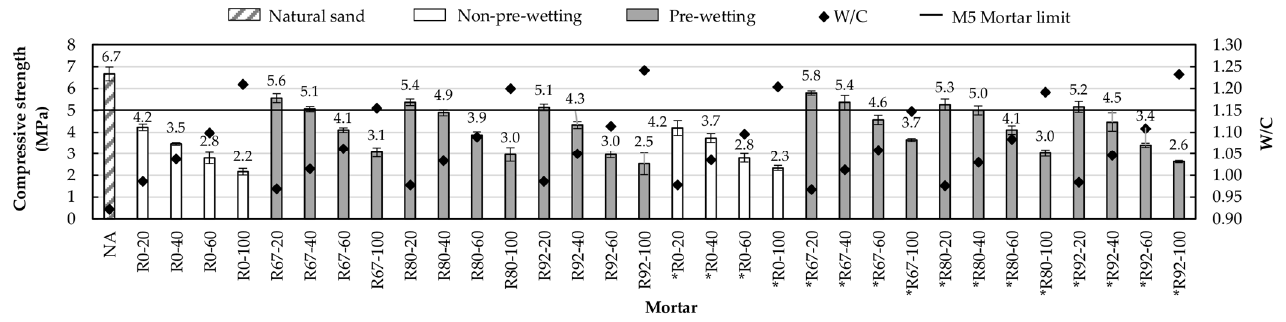
Figure 12. Values of compressive strength and W/C ratio.